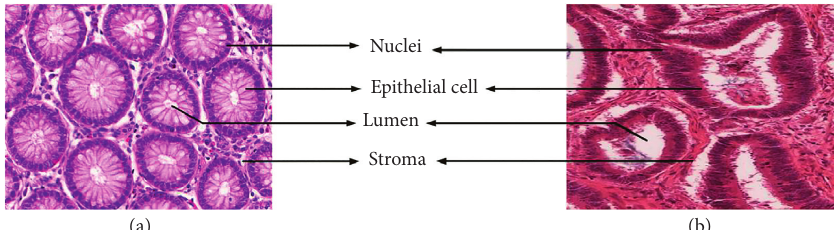
Figure 1: Illustration of colon images. (a) A typical benign colon gland histopathology image and its composition. (b) A malignant colon gland